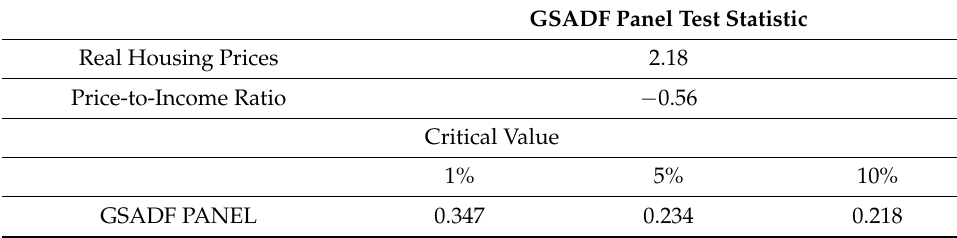
Table 3. Results of the univariate estimation of panel test statistics (GSADF PANEL).